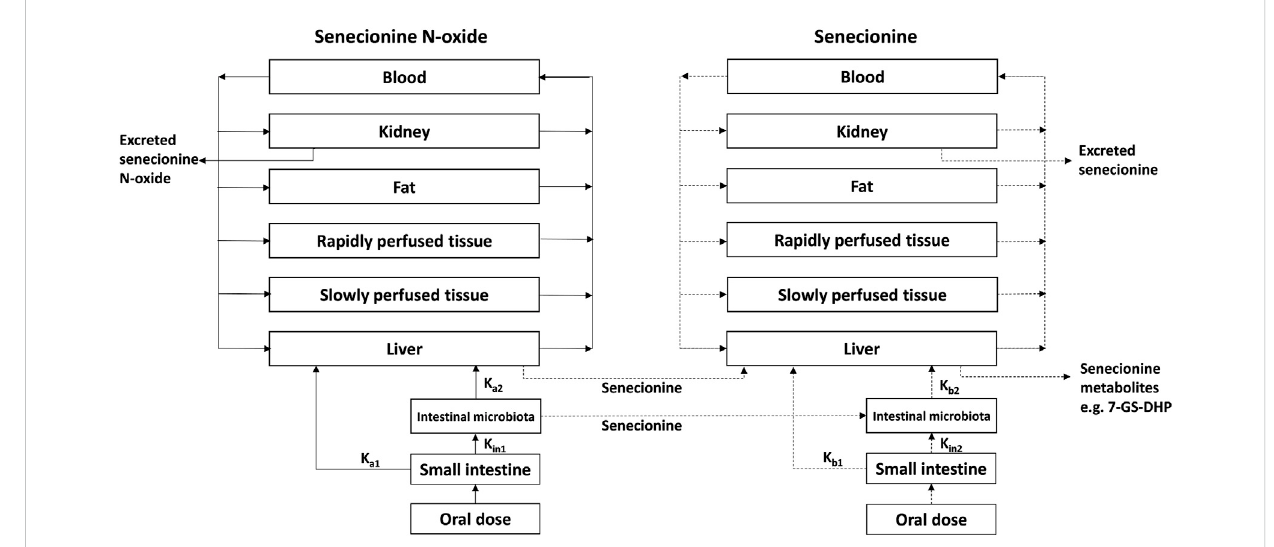
FIGURE 3 PBK model for SENO with a submodel for SEN as adapted from Widjaja et al. (Widjaja et al., 2022a) with the addition of 7-GS-DHP